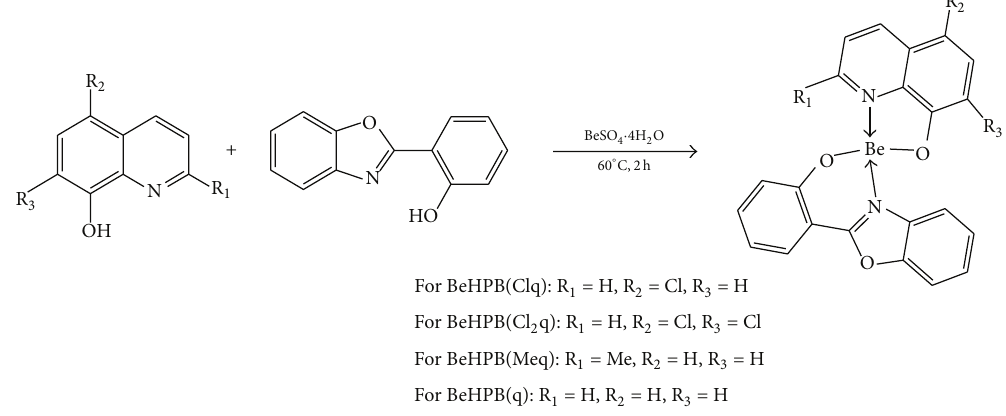
Figure 1: Synthetic route of the beryllium